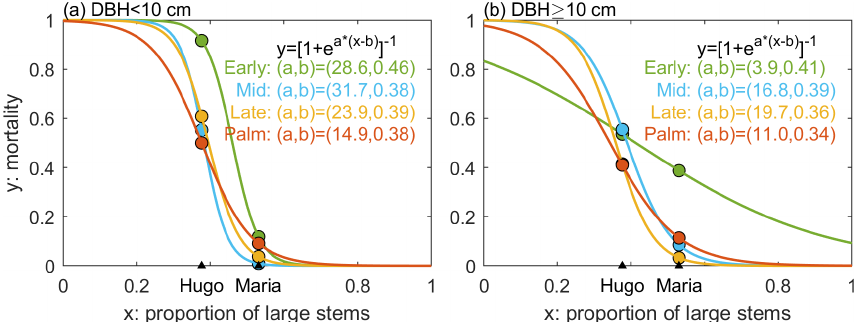
Figure 2. The mortality as a function of the size structure of the forest for each PFT and DBH class. The size structure is represented as the proportion of large stems (DBH ≥ 10cm) to the total number of stems in the forest (DBH ≥ 2 . 5cm). The dots represent observed mortality and proportion of large stems pairs from Hurricane Hugo and Hurricane Maria (Zhang et al., 2022b). Four colors represent four PFTs. The solid lines represent the estimated mortality as a logistic function of the proportion of large stems. The panel on the left is for small stems and that on the right is for large